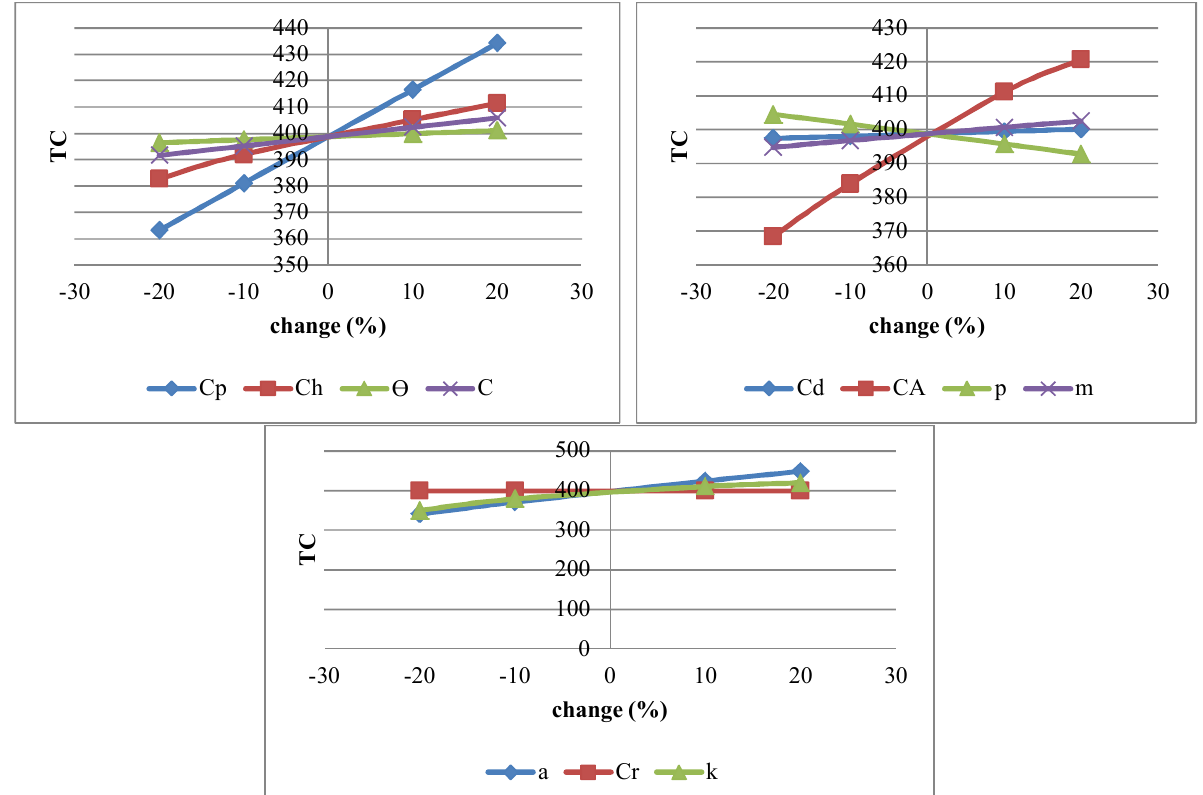
Fig. 10. (For example (1)) The effect of changing parameters on the optimal cost function